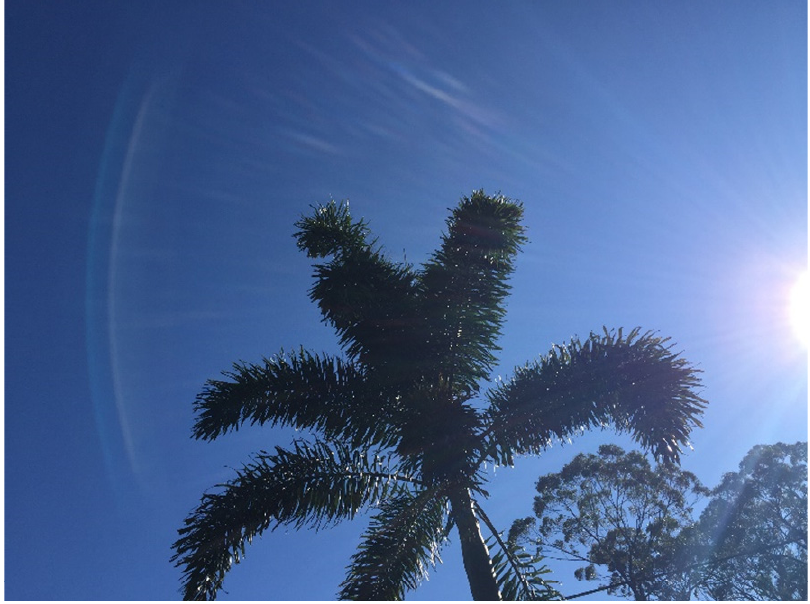
Figure 5. Maintaining a positive outlook: Sunny climate suggests nature promotes positivity.